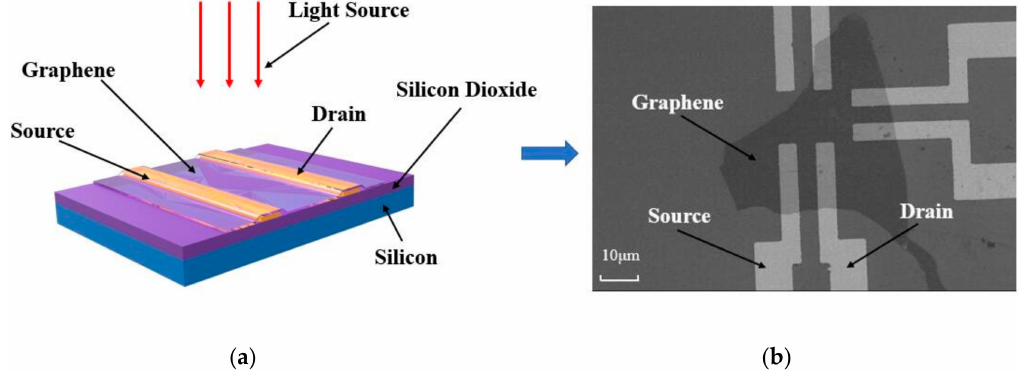
Figure 1. The structural diagram of the nano-device ( a ), and photograph of the nano-device taken with SEM ( b